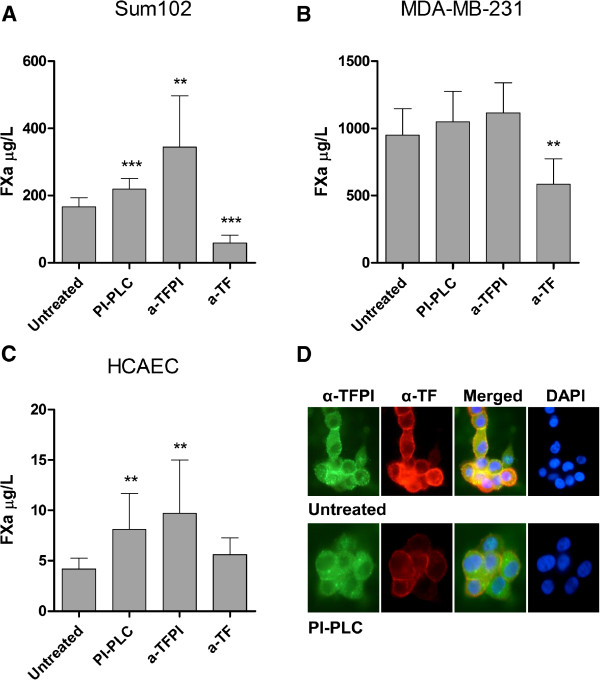
Cell surface anticoagulant activity of PI-PLC treated cells. Confluent Sum102, MDA-MB-231, and HCAEC cells grown in 24-wells trays were treated with SFM (untreated), PI-PLC, monoclonal anti-TFPI antibody, or anti-TF antibody for 2 hours before the supernatant was removed and cells were washed and assayed for TF activity. Sum102 (A), MDA-MB-231 (B), and HCAEC (C) cells were incubated with FVIIa and FX for 1 hour before the reaction was stopped and a substrate to FXa was added. The results were analyzed colorimetrically at 405 nm. The amount of FXa generated is displayed as mean mU/mL + SD (n ≥ 7) of three to four independent experiments. Statistical comparisons were conducted between PI-PLC treated samples and untreated controls. (D) Fluorescence images of SFM + Glycerol (untreated, upper panels) and PI-PLC (bottom panels) treated Sum102 cells stained with antibodies against both isoforms of TFPI (green, left panels) and TF (red, middle-left panels). After merging the images, co-localization of the two antibodies was indicated by a yellow color (middle-right panels). Nuclear staining with DAPI is depicted in the left panels. One representative experiment of three is shown.